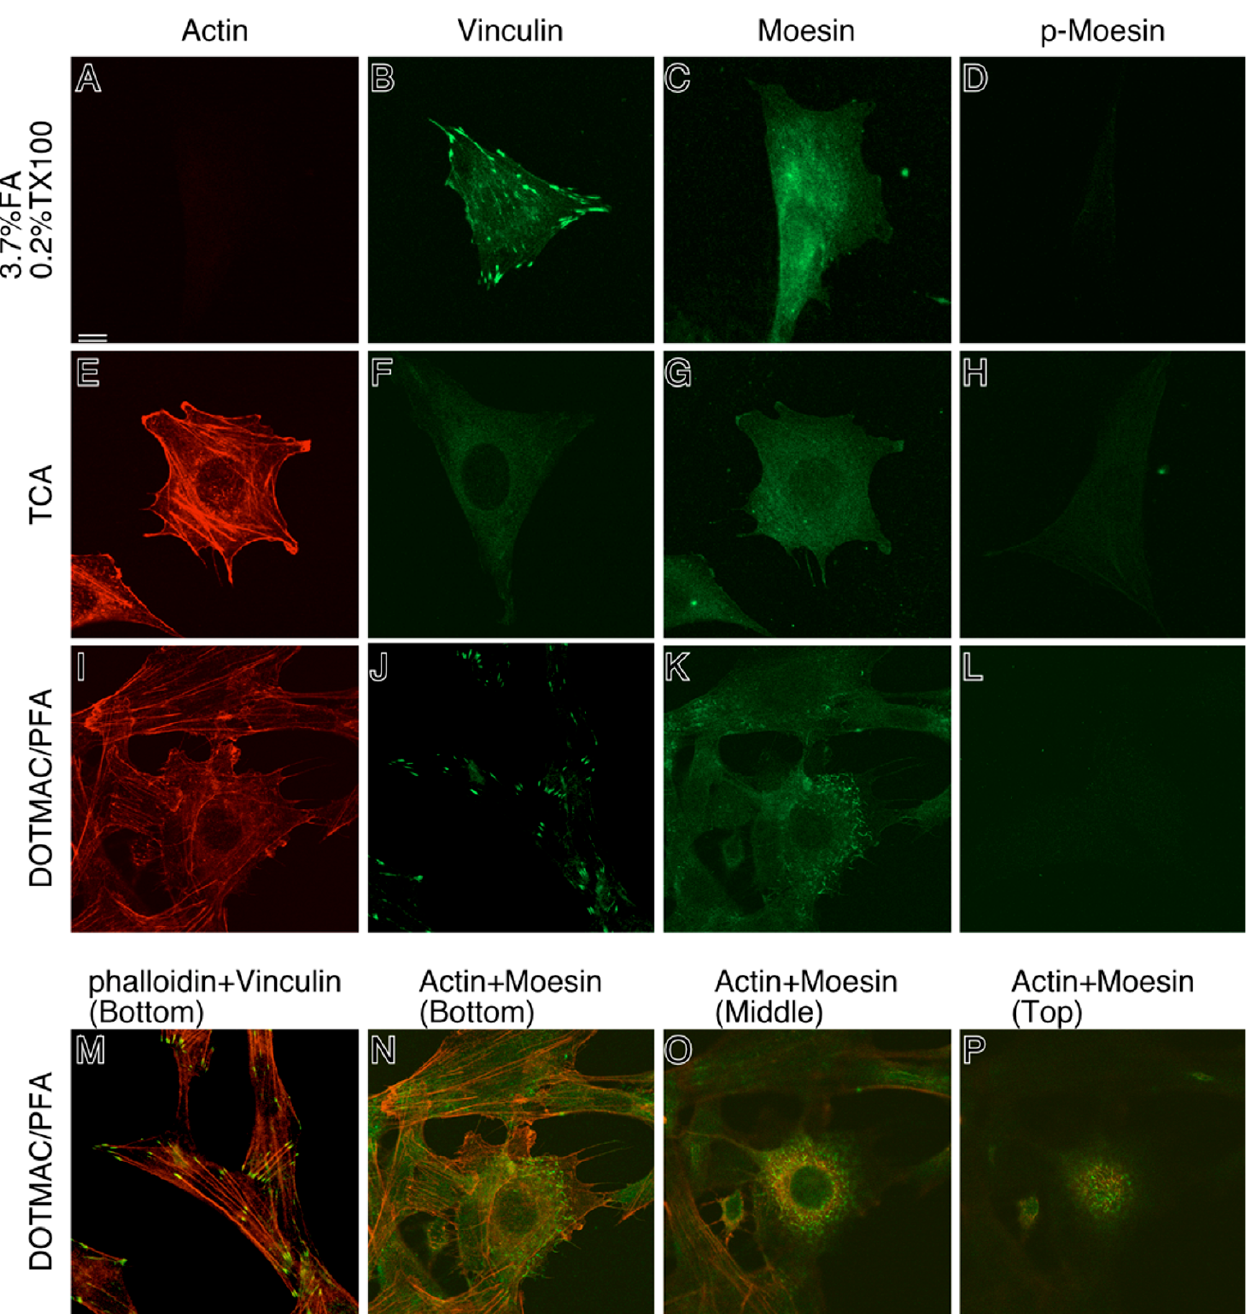
Figure 4 Comparison of fluorescence labeling of actin, vinculin, moesin and threonine558-phospho-moesin in NIH3T3 cells. Cells were rinsed with PBS(+) and fixed with TX100 (3.7% FA/0.2% TX100, see Table 1, A-D), TCA (see Table 1, E-H), or DOTMAC/PFA (see Table 1, I-L). Cells were double labeled with β -actin monoclonal antibodies (A5441) and a secondary antibody reagent conjugated to TRITC (A, E, and I), as well as with moesin polyclonal antibodies and secondary antibodies con- jugated to FITC (C, G, and K). Vinculin and threonine558-phospho-moesin were also stained with vinculin monoclonal (B, F, and J) and threonine558-phospho-moesin polyclonal antibodies (D, H, and L), followed by FITC-conjugated anti-rabbit IgG. Note that the fluorescence intensity of each samples varied as summarized in Table 2. Images are shown at optimum fluores- cence intensity. (M) Double exposure of J and TRITC-phalloidin-counterstained cells fixed with DOTMAC/PFA method. (N-M) Double exposure of I and K at different level of focus. Bars, 10 µ